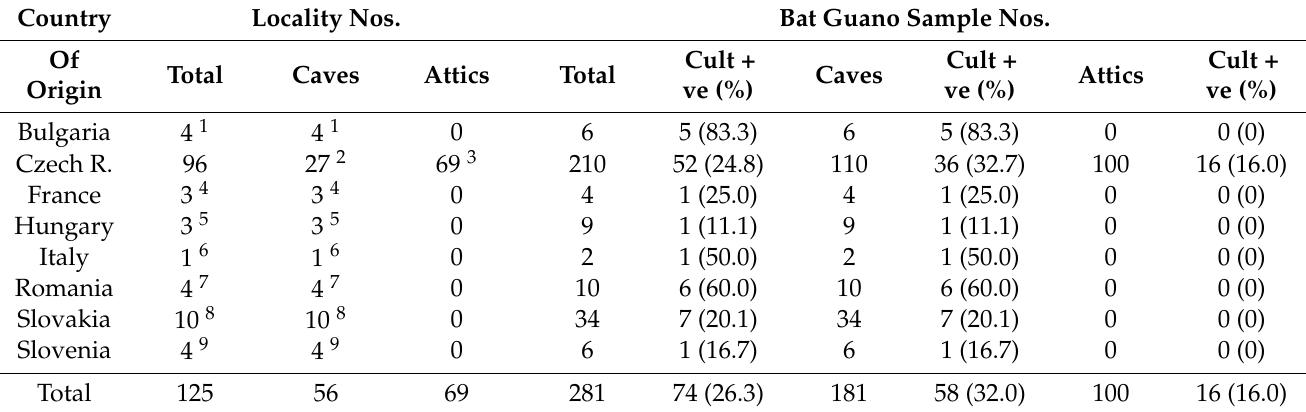
Table interpretation. 1 Bulgaria: Lovech Region, Devetashka Cave, Sofia Province, Temnata Dupka Cave, Cevdarska Cave and Vidin Province, Kozarnika Cave; 2 Czech Republic, Caves in Moravian Karst: Amaterska Cave, Part Stara Amaterska Cave, Balcarka Cave, Barova Cave, Byci skala Cave System (Svozilova Cave, Dragonback Ridge, Pagan Chimney, and Southern Branch), Cisarska (Eniodis) Cave, Hedvabna Sinkhole Cave, Jestrabka Cave, Katerinska Cave, Kralova Cave, Marianska Cave, Mastny Flek Cave, Mine No. 4 in Josefovske Valley, Nad Svycarnou Cave, Nova Rasovna Cave, Ochozska Cave, Pekarna Cave, Pod Hradem Cave, Ricka I Karst Resurgence, Rudicke propadani Cave System, Slloupsko-Sosuvske Caverns, Sloupsko-Sosuvske Caves, Stara Dratenicka Cave, Suchozlebska Zazdena Cave,